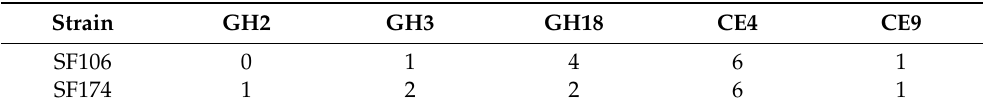
Table 2. Number of putative genes for the CAZymes categories in SF106, SF174 and selected probi- otic strains of the respective species.